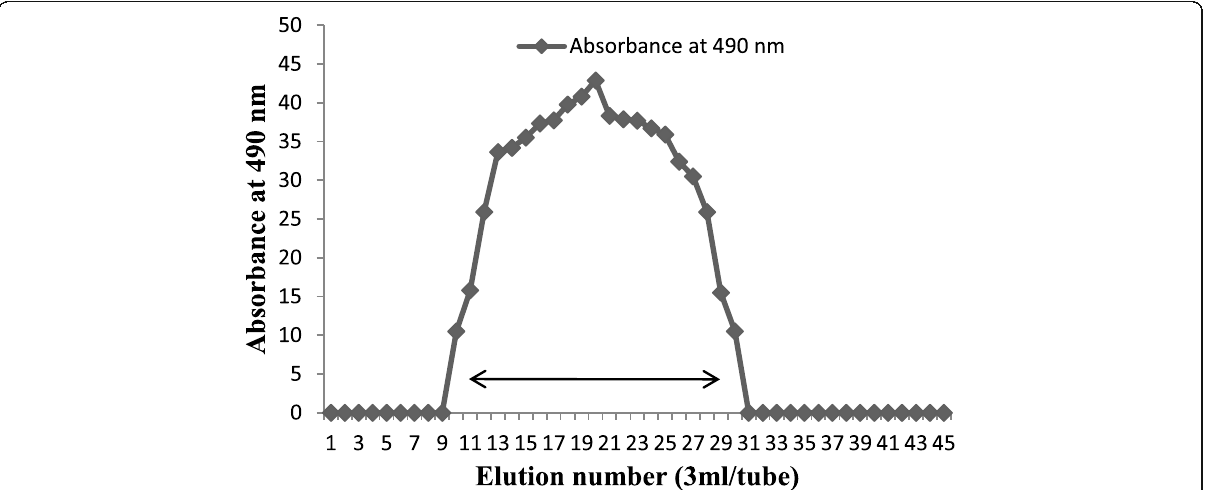
Fig. 1 The crude EPS obtained from the treatment with TCA and subsequently with cold ethanol of the growth medium supernatant of L. paraplantarum KM1 was fractionated on sephadex G75 chromatography